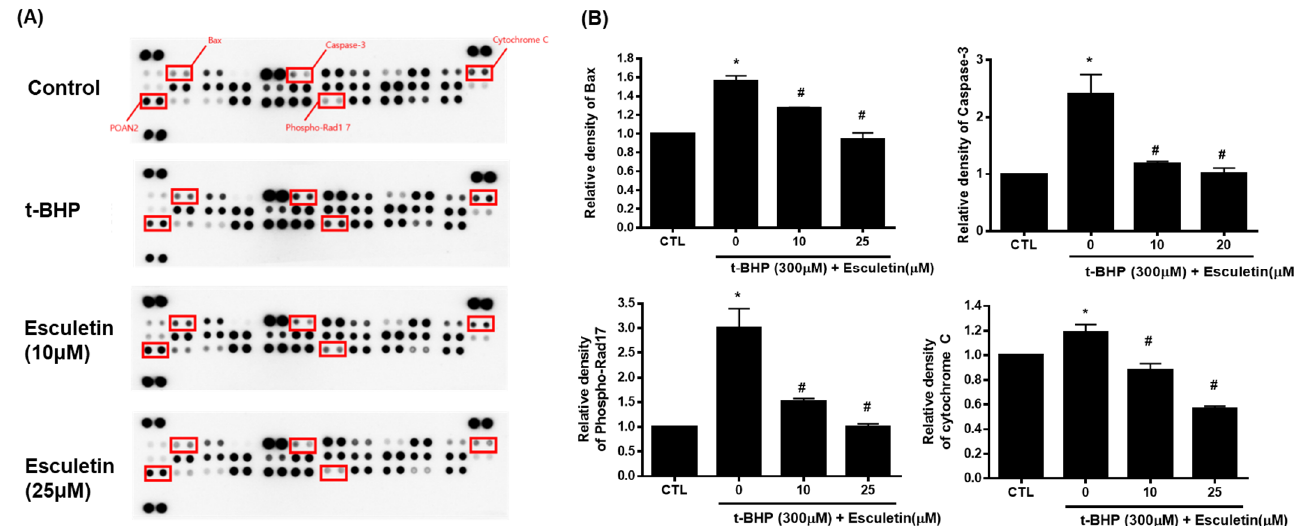
Figure 3. Effect of esculetin on t-BHP-induced apoptosis in HEK293 cells. ( A ) Apoptosis of HEK253 cells exposed to t-BHP with esculetin were detected using TUNEL staining. ( B ) In the bar graphs, the values represent means ± SD, n = 5. * p < 0.05 vs. untreated control group, # p < 0.05 vs. t-BHP-treated group.